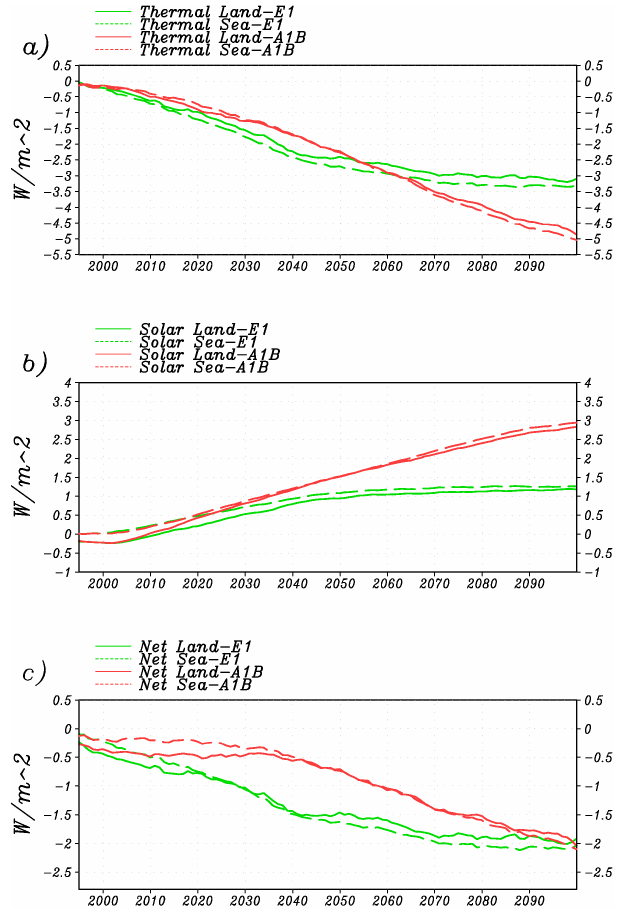
Fig. 8. Comparison of 15-years running means of the change in atmospheric vertical divergence for (a) Thermal radiation, (b) Solar radiation, and (c) Net (Solar + Thermal) radiation with reference to 1970-2000 climatology. Land averages (solid lines) and sea averages (dashed lines) are reported for both A1B (red) and E1 (green) scenarios.